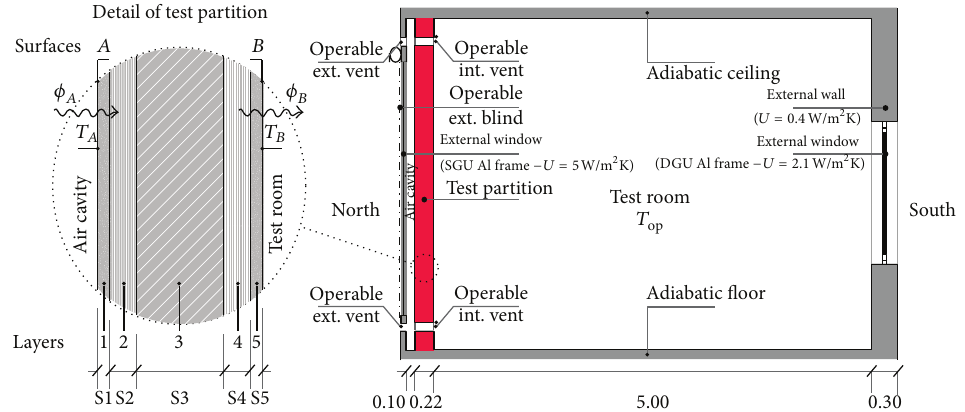
Figure 9: Test room section and details of test partition: (1–5) Temperature test partitions (S1 and S5) Plasterboard panel (S2 and S4) PCMs and (S3) Mineralized wood panel.